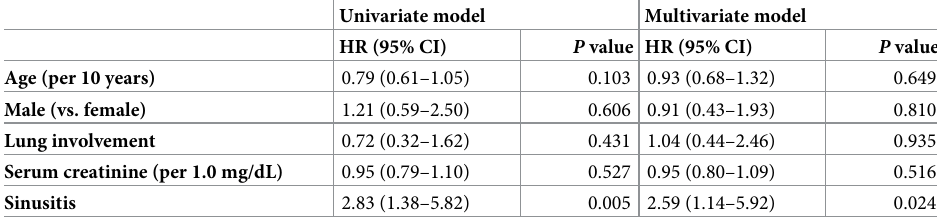
Table 3. Predictors of elevated MPO-ANCA levels.